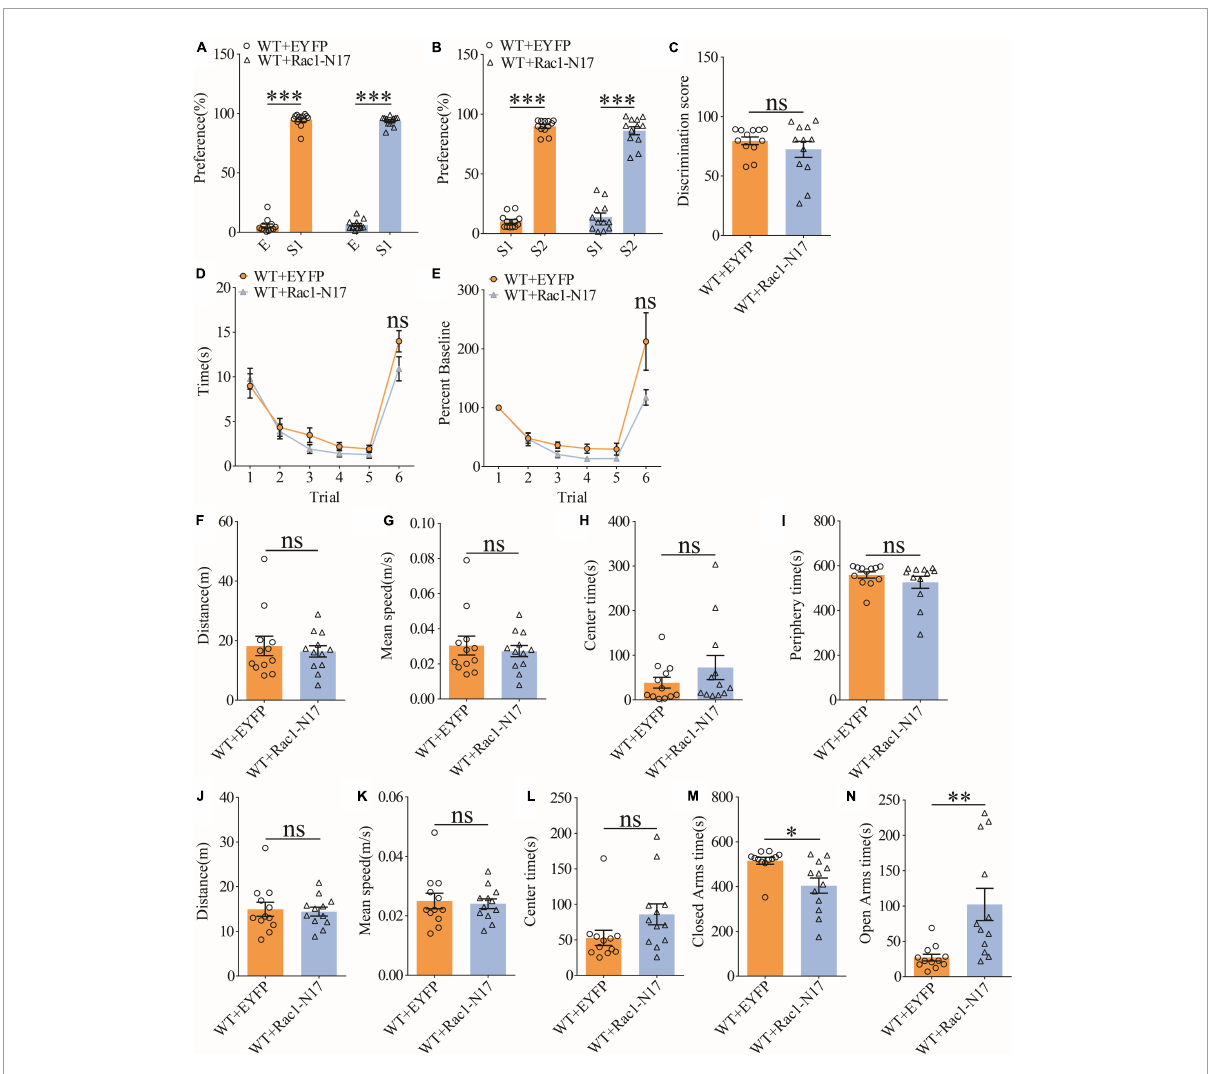
FIGURE7 Normal social recognition memory in WT mice overexpressing Rac1-N17. (A) Normal sociability during stage 2 of the three-chamber social test in WT mice expressing EYFP or Rac1-N17 (WT + EYFP: n = 12, p < 0.001; WT + Rac1-N17: n = 12, p < 0.001; two-tailed paired t -test). (B) Preference for S2 over S1 during stage 3 of the three-chamber social test in WT mice expressing EYFP or Rac1-N17 (WT + EYFP: n = 12, p < 0.001; WT + Rac1-N17: n = 12, p < 0.001; two-tailed paired t -test). (C) Discrimination scores during stage 3 of three-chamber social test showing no difference in social memory between WT mice expressing EYFP and Rac1-N17 ( p = 0.345, two-tailed t -test). (D) Similar performance in the five-trial social memory assay in WT mice expressing EYFP and Rac1-N17 during trials 1–5 (WT + EYFP: n = 12, WT + Rac1-N17: n = 12; genotype: F ( 1 , 11 ) = 0.010, p = 0.921; trial: F ( 4 , 44 ) = 11.380, p < 0.001; repeated two-way ANOVA) and on trial 6 ( p = 0.100, two-tailed t -test). (E) Normalized interaction time showing similar performance in WT mice expressing EYFP and Rac1-N17 during trials 1–5 (WT + EYFP: n = 12, WT + Rac1-N17: n = 12; genotype: F ( 1 , 11 ) = 0.532, p = 0.485; trial: F ( 4 , 44 ) = 29.120, p < 0.001; repeated two-way ANOVA for trials 1–5) and on trial 6 of the five-trial social test ( p = 0.083, two-tailed t -test). (F) Open field test showing comparable